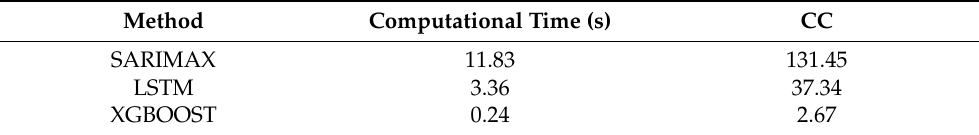
Table 5. Computational complexity for multivariate time